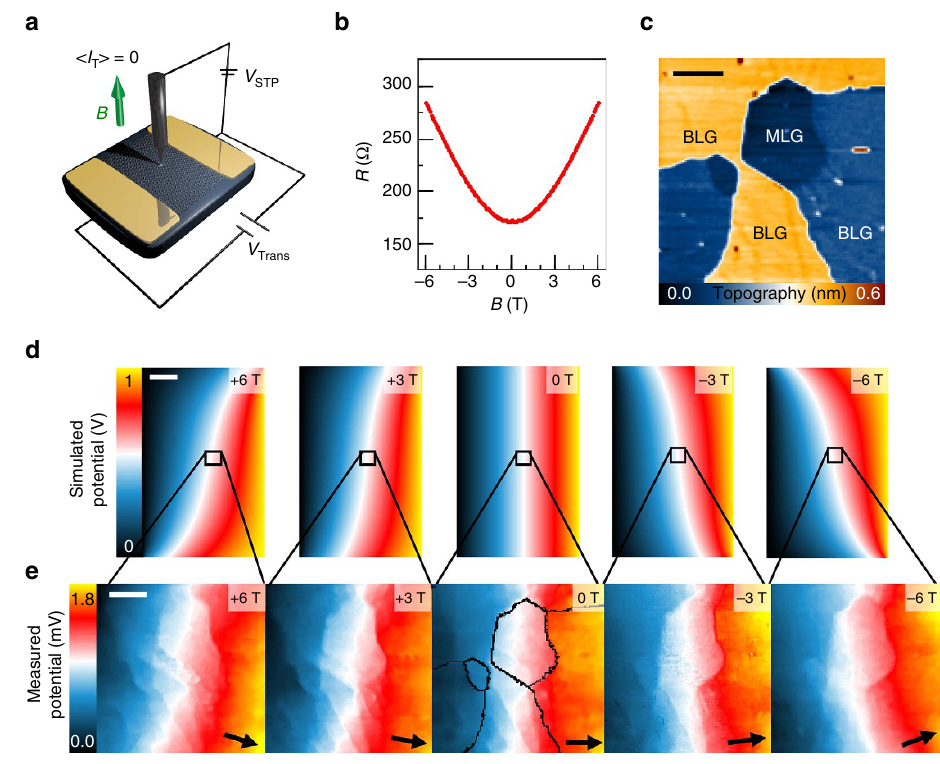
Figure 1 | Scanning tunnelling potentiometry with applied magnetic field. ( a ) Schematic of the set-up: large samples of epitaxial-grown graphene on SiC(0001) consisting of MLG and BLG are contacted in two-terminal geometry. The voltage V STP x ; y ð Þj necessary to compensate a net tunnel current I T I T ¼ 0 is recorded and mapped. It represents the voltage drop along the sample induced by the cross voltage V Trans . A transverse magnetic field up to 6T can additionally be applied. ( b ) Macroscopic resistance R ( B ) of one of the investigated samples as a function of magnetic field B . ( c ) Topography of a typical sample area showing a MLG island surrounded by BLG (440 (cid:5) 440nm 2 , scale bar, 100nm, I T ¼ 0.2nA/ V Bias ¼ (cid:2) 50mV). ( d ) Magnetic field-dependent potential landscape for one of the samples in b for a cross voltage V Trans ¼ 1V obtained by resistor network simulations (1.6mm (cid:5) 1.1mm, scale bar, 250 m m, see Supplementary Notes 1 and 2 and Supplementary Figs 1–4). ( e ) Local potential maps for different magnetic